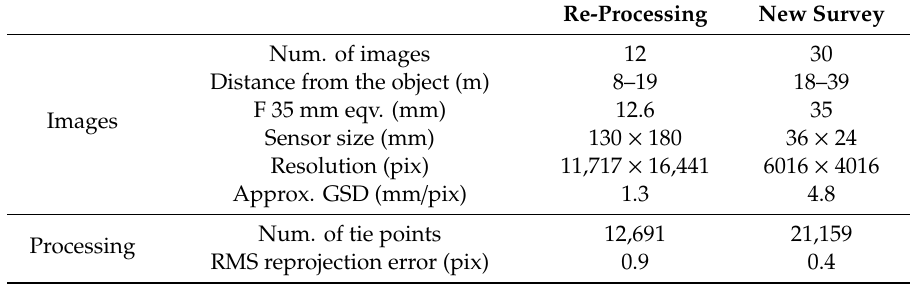
Table 5. Comparison of datasets of the re-processing and the new survey.